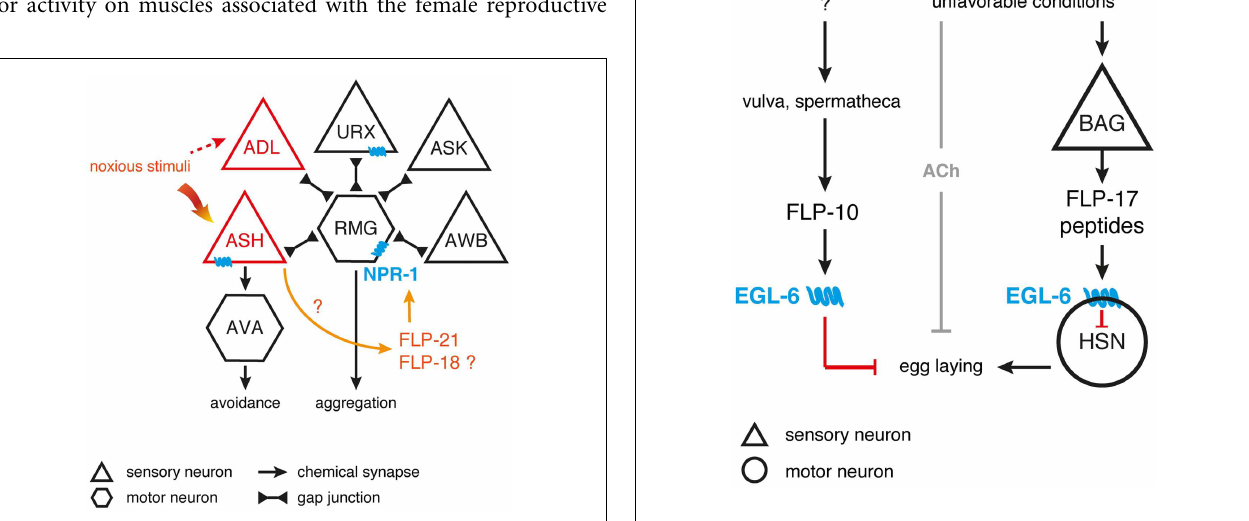
FIGURE 2 | Inhibition of the RMG interneuron by NPR-1 . Signaling from ASH and ADL neurons induces aggregation through gap junctions with RMG. RMG is the hub neuron of a gap junction network connecting various sensory neurons known to trigger aggregation. ASH and ADL also mediate acute avoidance behavior through synaptic signaling. Both types of connections are differentially regulated by the NPR-1 receptor, with FLP signaling inhibiting the gap junction driven activation of RMG and not being essential to ASH-mediated avoidance [adapted from Ref. (100, 151)].